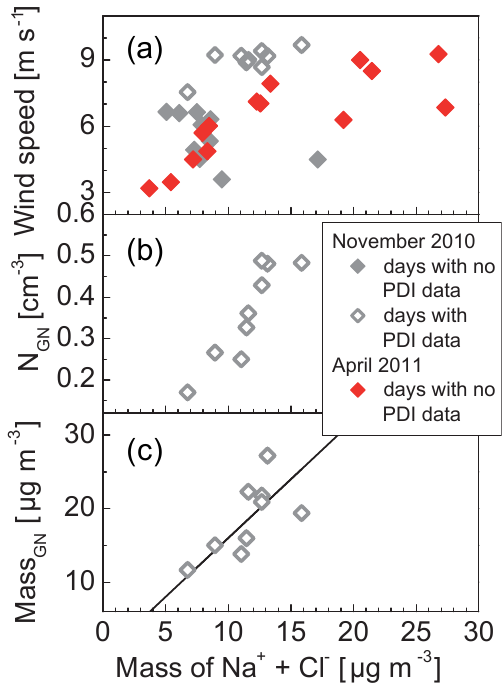
Figure 11. Mass concentrations of Na + + Cl − from filter samples taken at Ragged Point in comparison to wind speed (upper panel) and to number and mass concentrations (middle and lower panel, respectively) of particles detected with the PDI in the